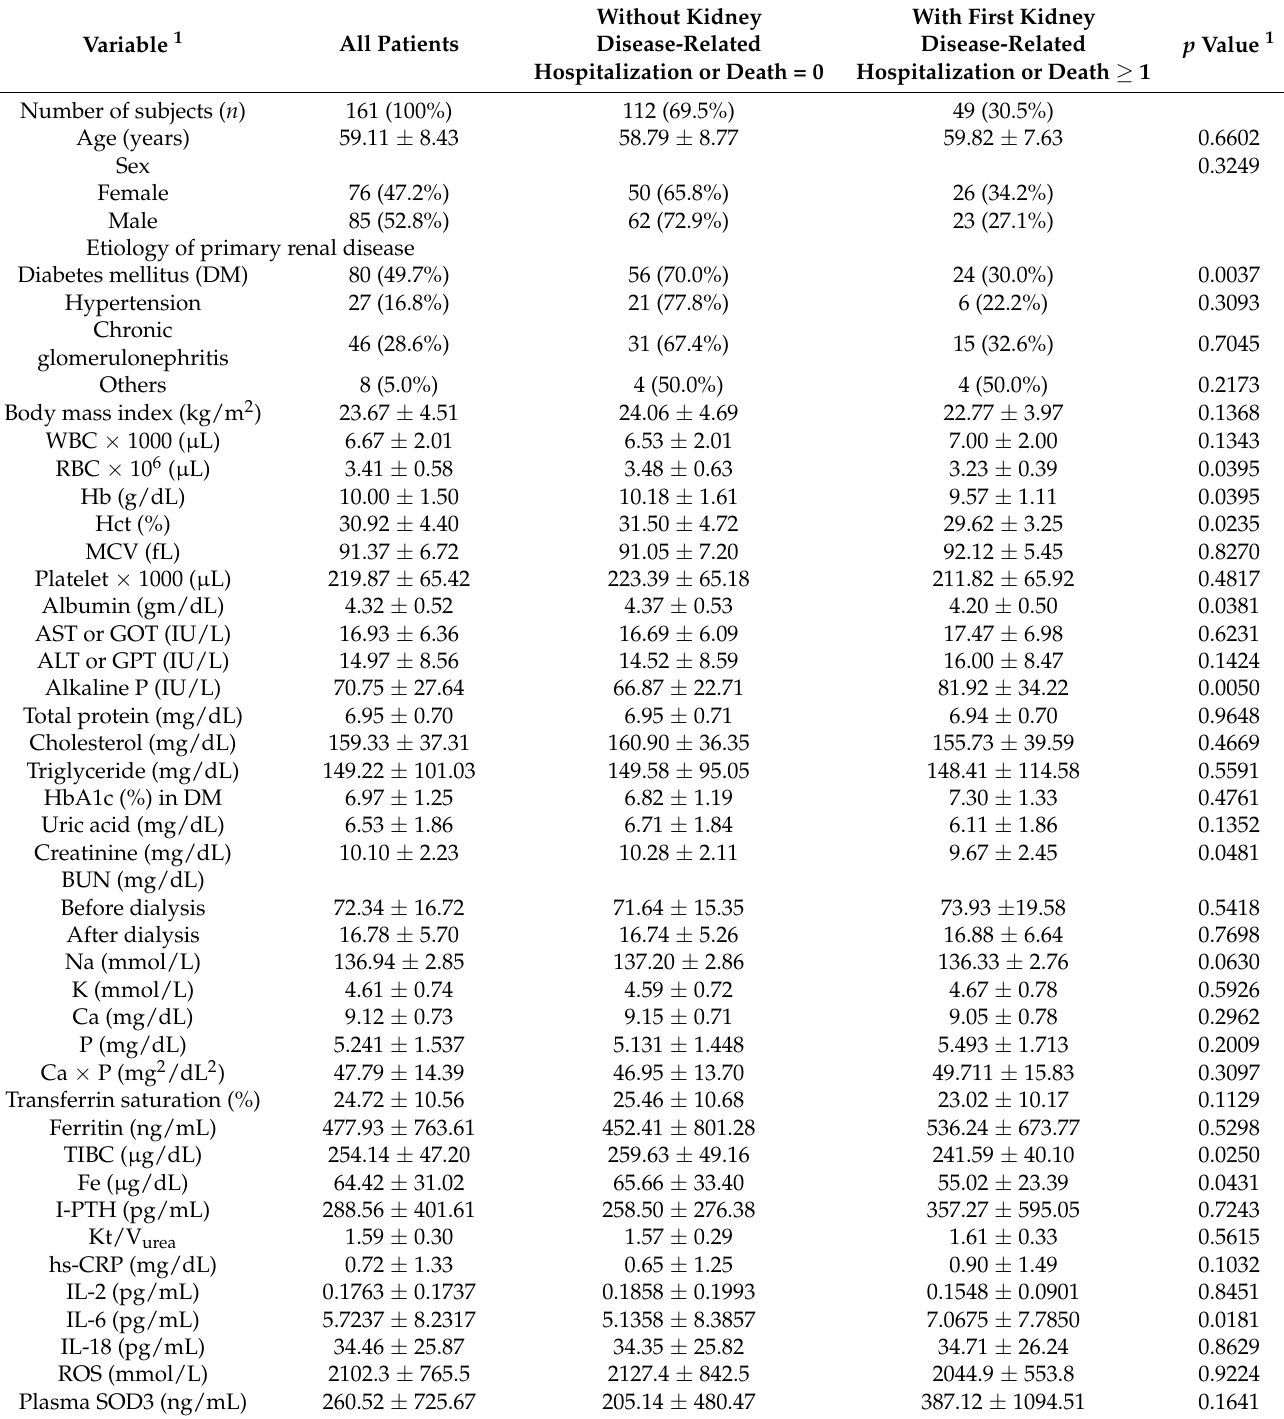
Table 1. Comparisons of demographic and clinical characteristics between ESRD patients with- out kidney disease-related hospitalization or death and those with a first kidney disease-related hospitalization or death during the follow-up